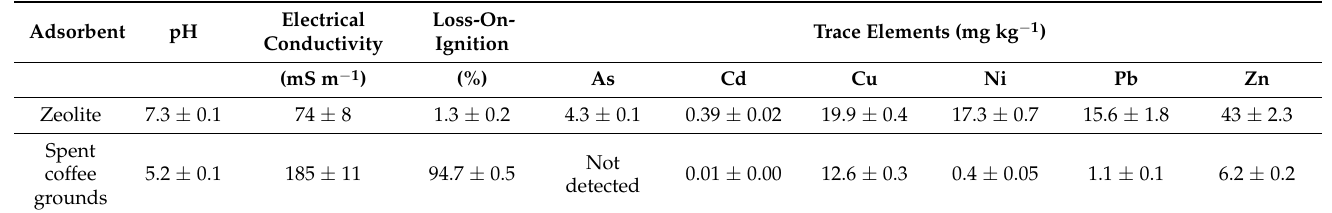
Table 4. Selected physicochemical properties of zeolite and spent coffee grounds. Own compilation based on literature data